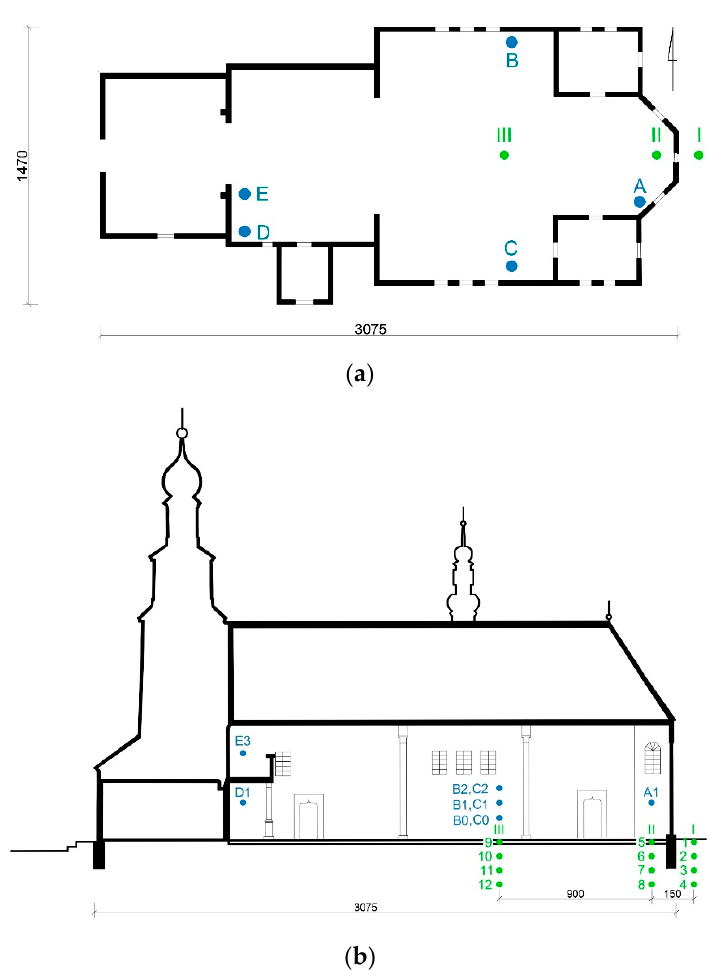
Figure 3. Location of measurement points: ( a ) projection; ( b ) cross-section; A1, B0, B1, B2, C0, C1, C2, D1, E3—air temperature and relative humidity measurement points; I, II, III—floor and soil temperature measuring risers; 1–12—floor and soil temperature measuring points.